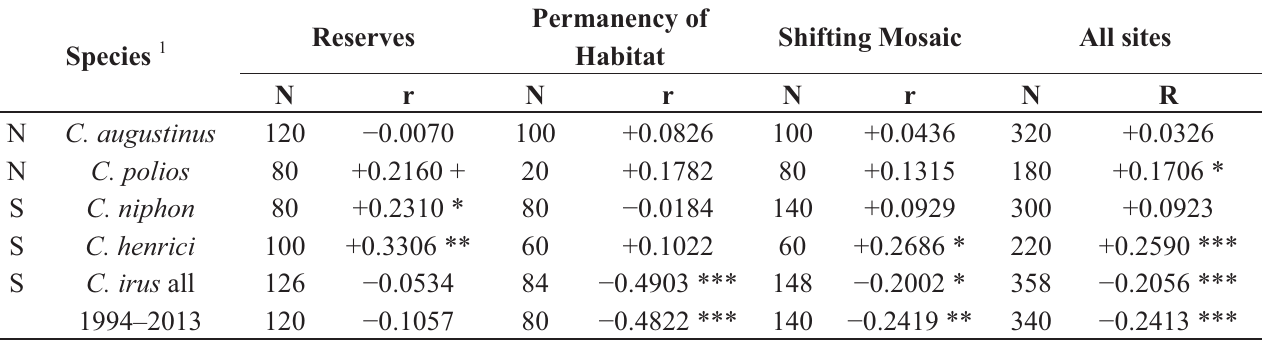
Table 12. Spearman rank correlation coefficients (r) of abundance (individuals per hour on peak count per site per year) and year (trend over time), by species and site